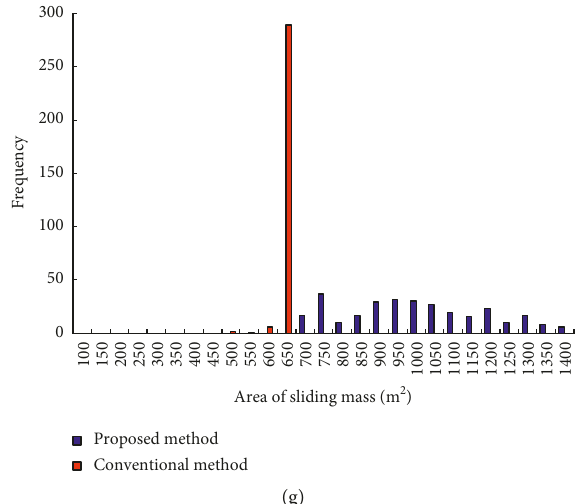
Figure 11: Comparison of histogram of area of sliding mass between conventional method and proposed method at different λ values (note that the number of samples in MCS